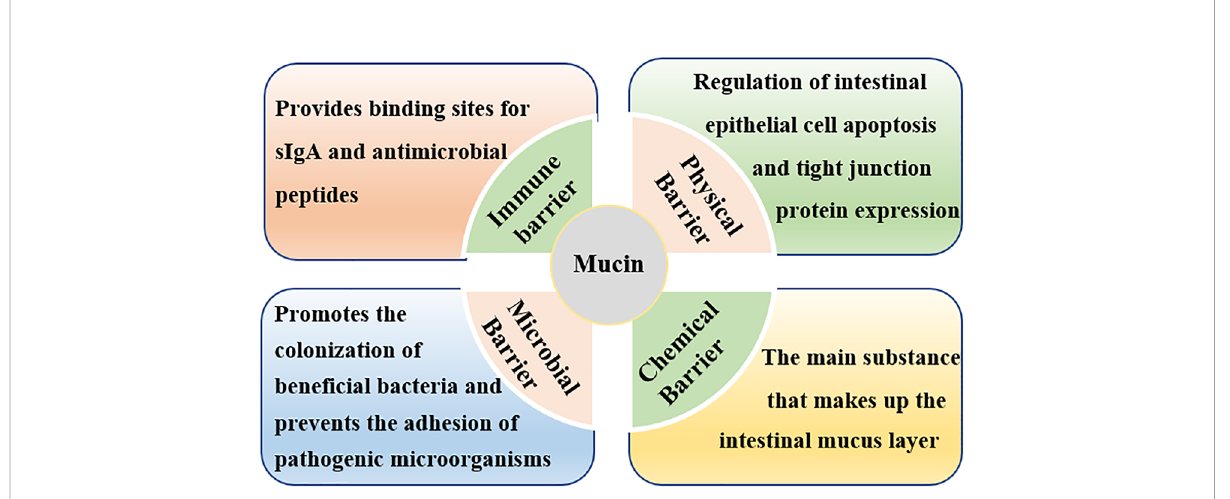
FIGURE 3 Roles of intestinal mucins in intestinal barrier function. Mucins maintain intestinal barrier function by affecting the mechanical barrier, chemical barrier, immune barrier, and microbial barrier.